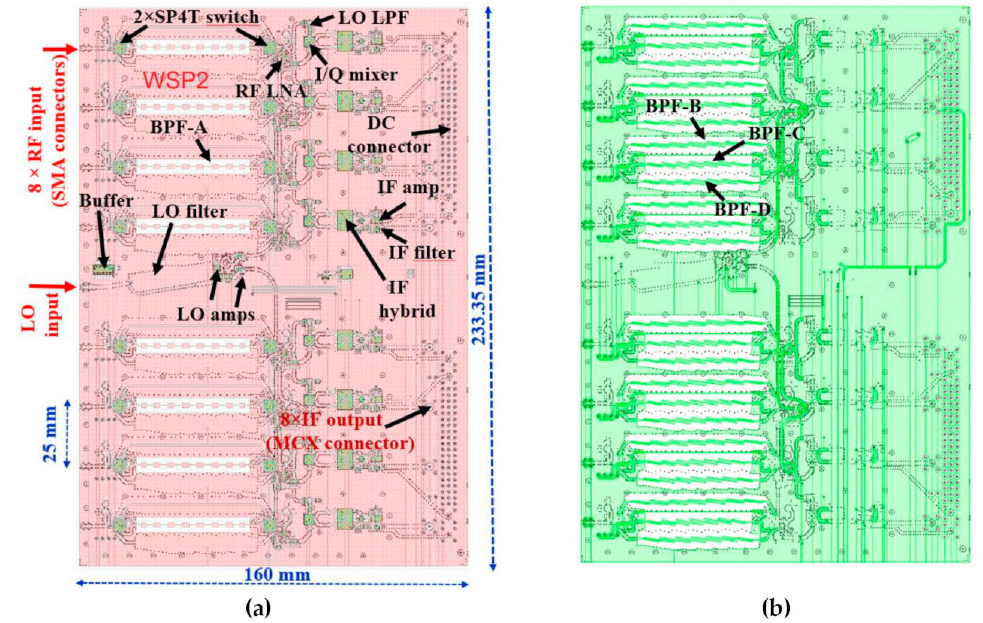
Figure 7. WS RF / IF board design. View of two di ff erent PCB layers. ( a ) Top metallization layer with components showing the BPF-A layer; ( b ) Metallization layer n. 3, showing the BPF-B, BPF-C and BPF-D.